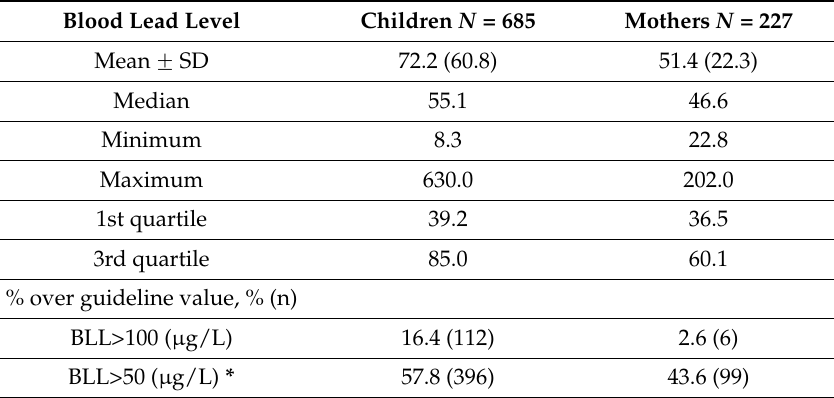
Table 1. Blood lead level (BLL, µ g/L) in children 12 to 24 months old and mothers at 18 months post-partum in Allada, Benin. Blood Lead